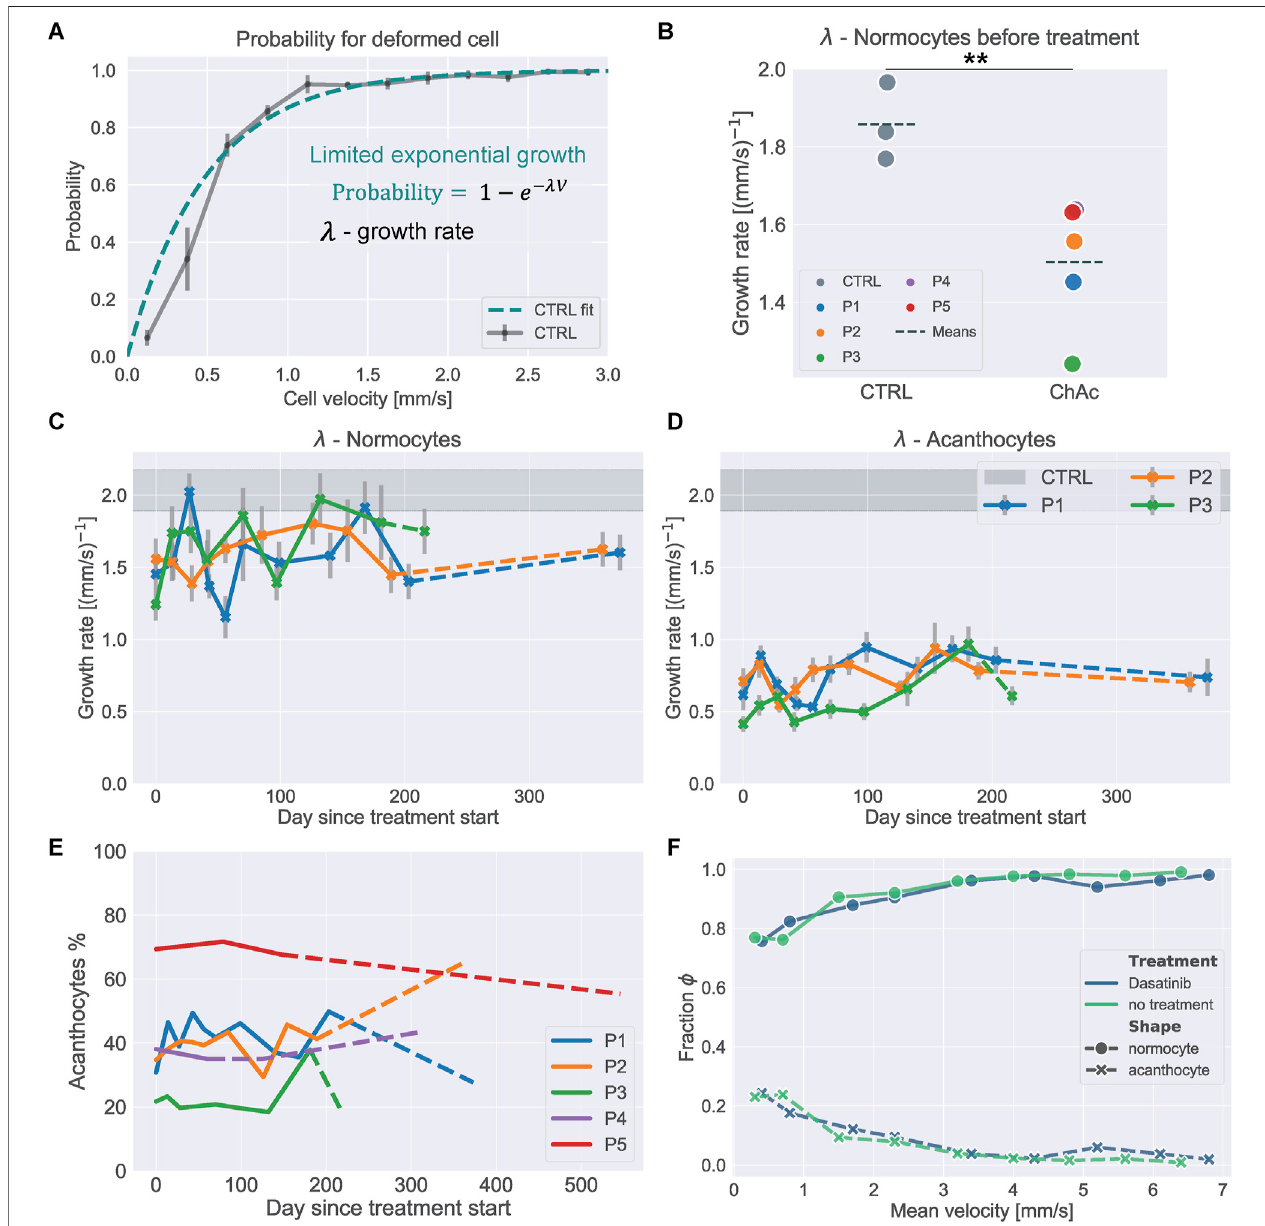
FIGURE2| Dasatinibtreatmenteffect onRBCdeformability. (A) Illustration ofthelimited exponentialgrowth function fi t,usedtocharacterizetheshape probability curvespresentedonthecontroldata. (B) Fittedgrowthratefornormocytesofcontrolsamplesvs.samplesfromChAcpatients. p -valuecalculatedbyWelch ’ s t -test( p = 0.009). (C) Fitted growth rate λ of the shape probability curves from ChAc patients as a function of treatment time with dasatinib for normocytes and (D) acanthocytes respectively. Dashed lines represent datapoints taken after treatment was stopped. Errorbars represent standard error of the fi t, calculated from the covariance matrix. Gray region shows the respective value from healthy donors without treatment (Mean ± SD). (E) Percentage of acanthocytesfound in each sample during shape analysismeasurementsforpatientsP1-P5.Dashedlinesindicatedatapointstakenaftertherespectivetreatmentalreadystopped. (F) Fractionofhealthyshapes(hs)and acanthocytes (ac) over cell velocity for untreated and in-vitro dasatinib treated RBCs from patient P3.